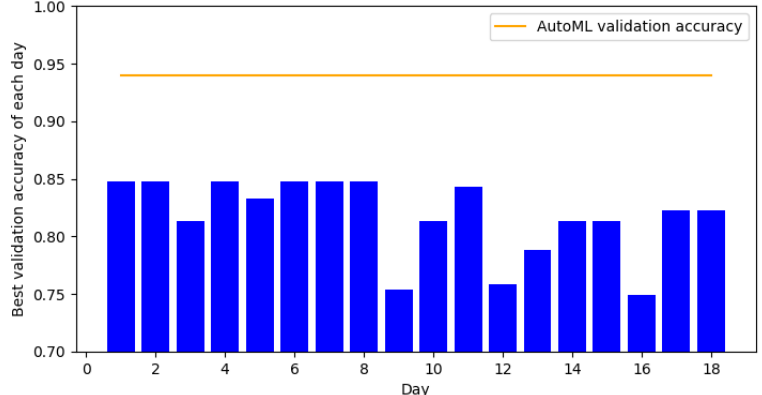
Figure 3. Validation accuracy over 18 days by the graduate student on the Heart UCI dataset.